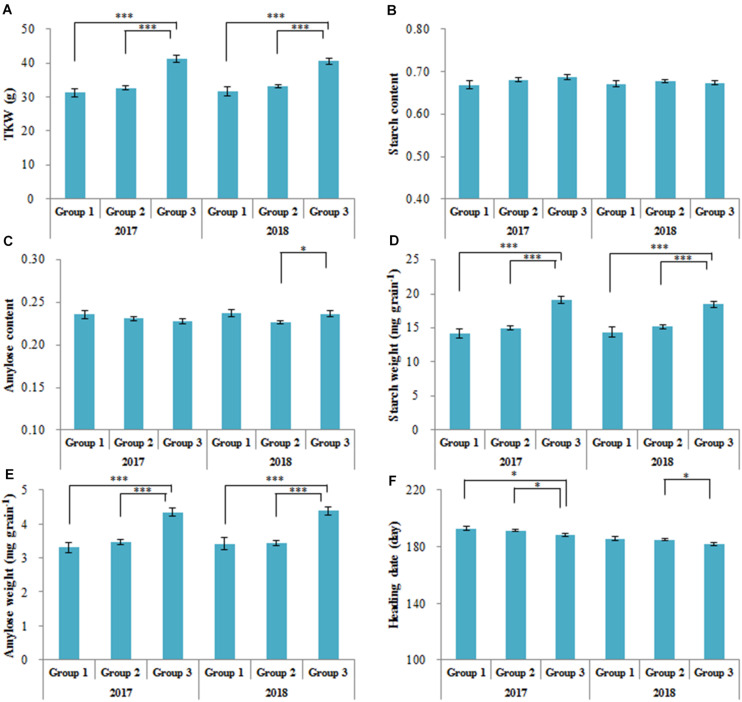
Agronomic traits of three groups (as in Figure 1) in 2017 and 2018. (A) Thousand kernel weight (TKW); (B) starch content; (C) amylose content; (D) starch weight per grain; (E) amylose weight per grain; (F) heading date. ∗P < 0.05; ∗∗∗P < 0.001.